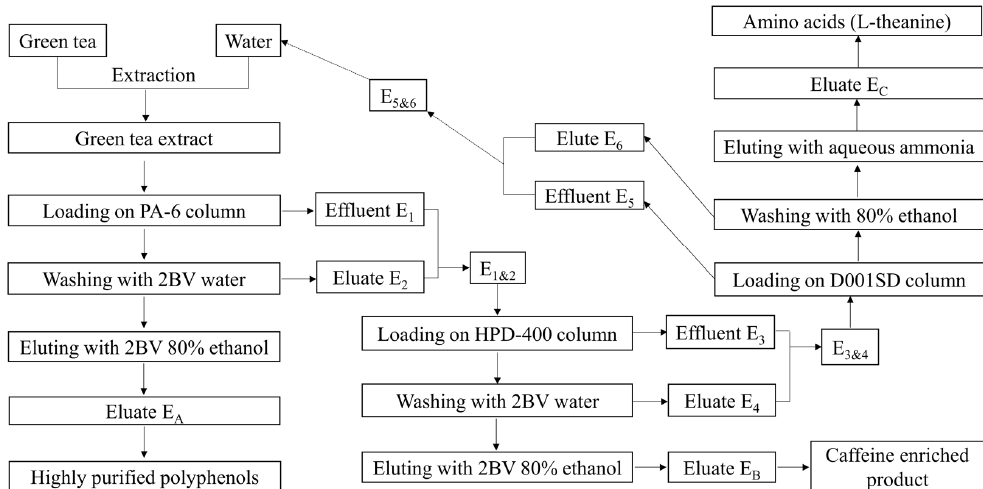
Figure 5. Simultaneous preparation of polyphenols, L-theanine and caffeine from green tea through column separation.